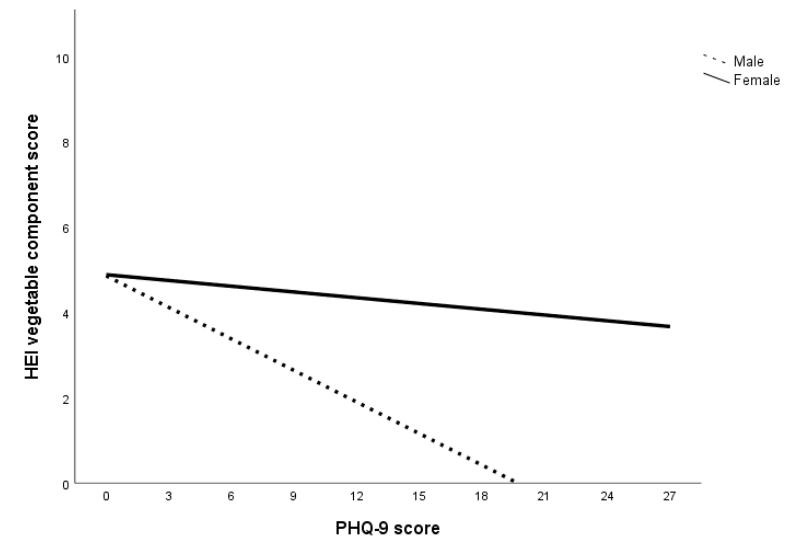
Figure 3. The relationship between depression and vegetable consumption across sex . Note. Lower HEI vegetable component score indicates lower consumption of vegetable.